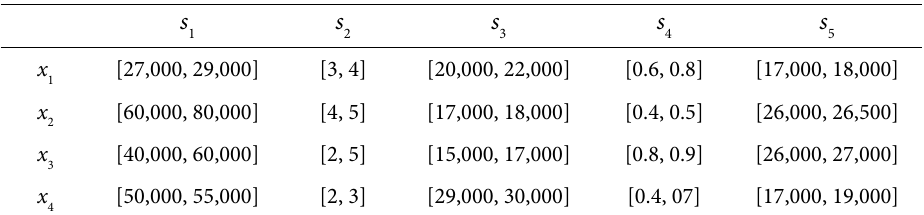
Table 4. Uncertain decision matrix